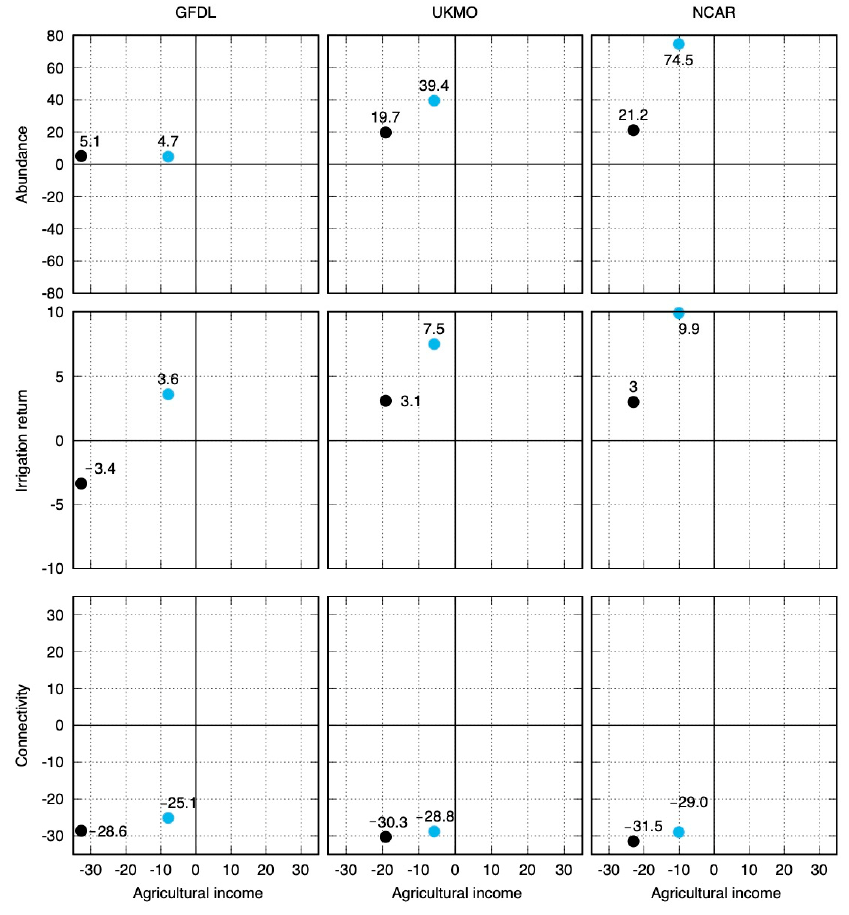
Figure 3. Tradeoff between selected performance measures and agriculture income; x -axis in all plots indicates agriculture income while the y -axis for each row of graphs from top to bottom are abundance, irrigation return, and connectivity; graph columns from left to right indicate climate scenarios GFDL, UKMO, and NCAR; value of hydrology indicators is labeled.